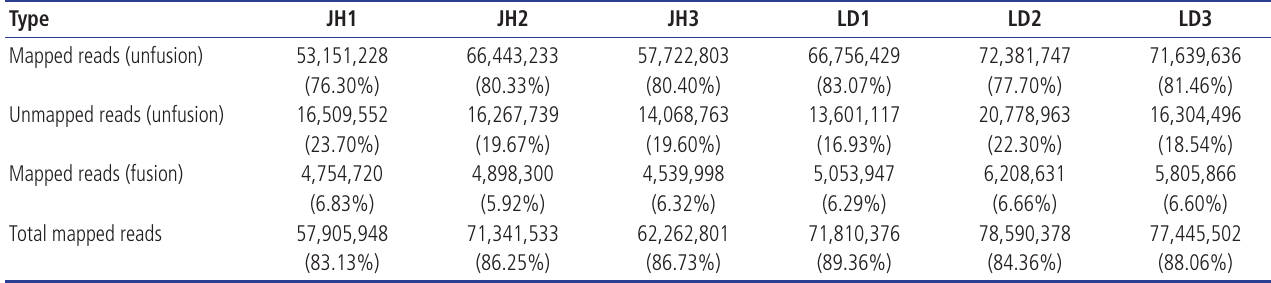
Table 1. Summary of the sequencing reads alignment to the reference genome Type